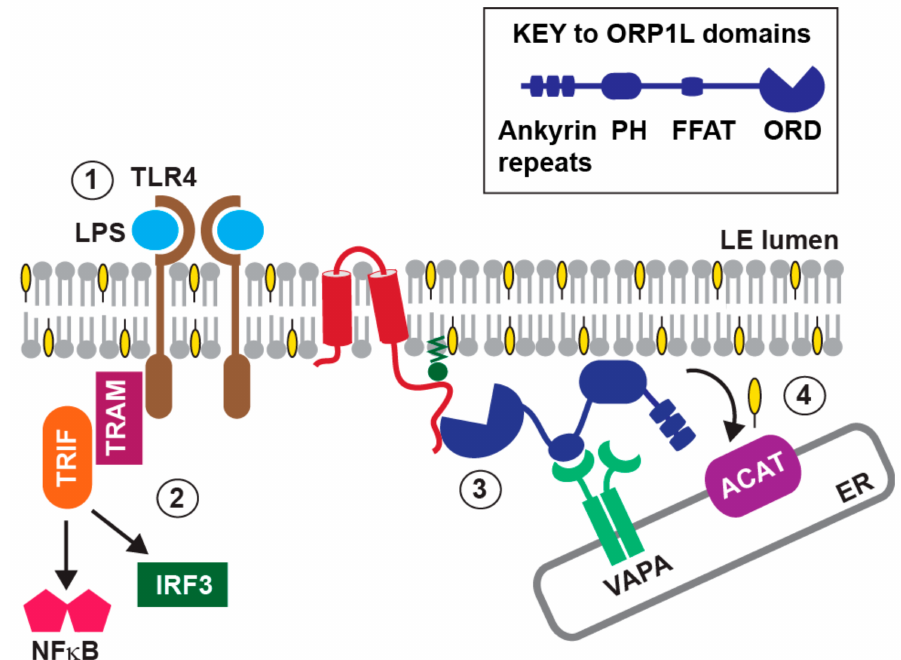
Figure 4. Hypothetical model for adenoviral regulation of cholesterol-dependent TLR4 signaling. It is already established that LPS-activated TLR4 tra ffi cs to endosomes, where it is associated with cholesterol (yellow)-enriched lipid rafts (1); and that endosomal TLR4 regulates NF κ B and IRF3 signaling by engaging TRAM / TRIF adaptors